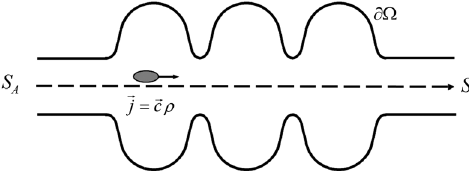
ð 4 Þ FIG. 2. Charged particle bunch moving through an accelerating